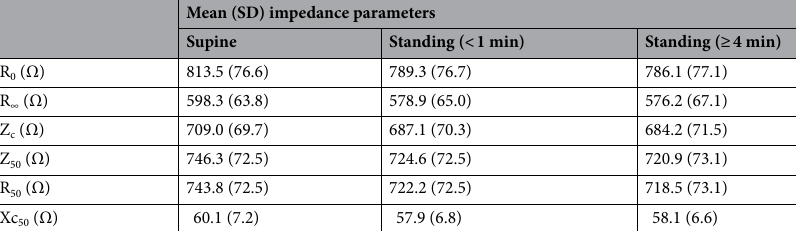
Table 2. Mean bioimpedance parameters when the participants were measured supine and standing (< 1 min and ≥ 4 min). R 0 resistance at 0 kHz, R ∞ resistance at infinite kHz, Z c impedance at the characteristic frequency,